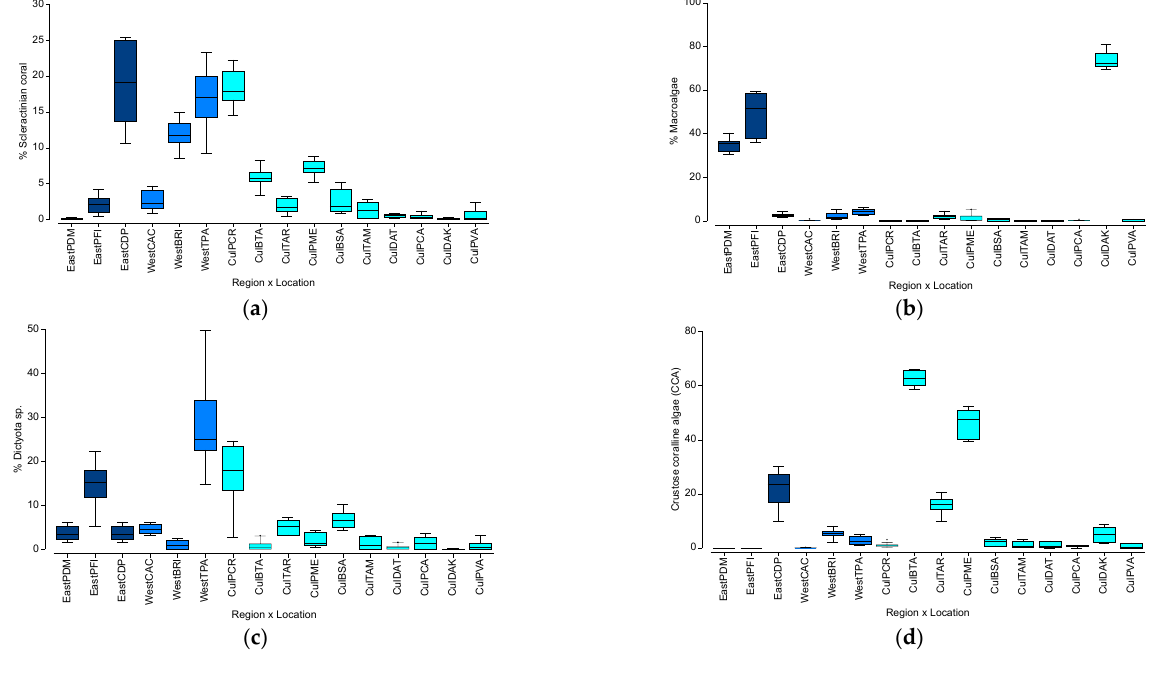
Figure 2. Spatial variation pattern in the percent cover of: ( a ) Scleractinian corals; ( b ) Macroalgae; ( c ) Dictyota spp., and ( d ) Crustose coralline algae (CCA). Refer to the Methodology for the description of